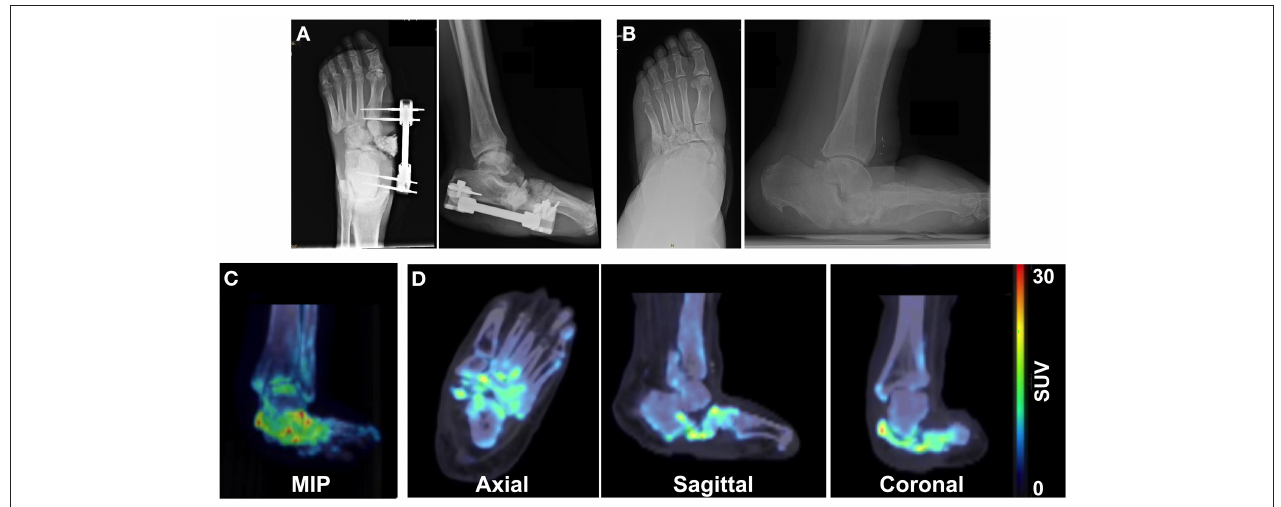
FIGURE 1 | Multimodality imaging evaluation of a 65-year old male patient with a history of Charcot foot, type 2 DM, and PAD. X-rays acquired at (A) the time of external fixation and (B) 5 years after surgery reveal the architecture of the foot. (C) Maximum intensity projection (MIP) images and (D) axial, sagittal, and coronal 18 F-NaF PET/CT images of the foot 5 years after surgery demonstrate focal increased uptake of 18 F-NaF in the bones of the foot, indicating ongoing physiological remodeling of the afflicted foot 5 years after surgical reconstruction.